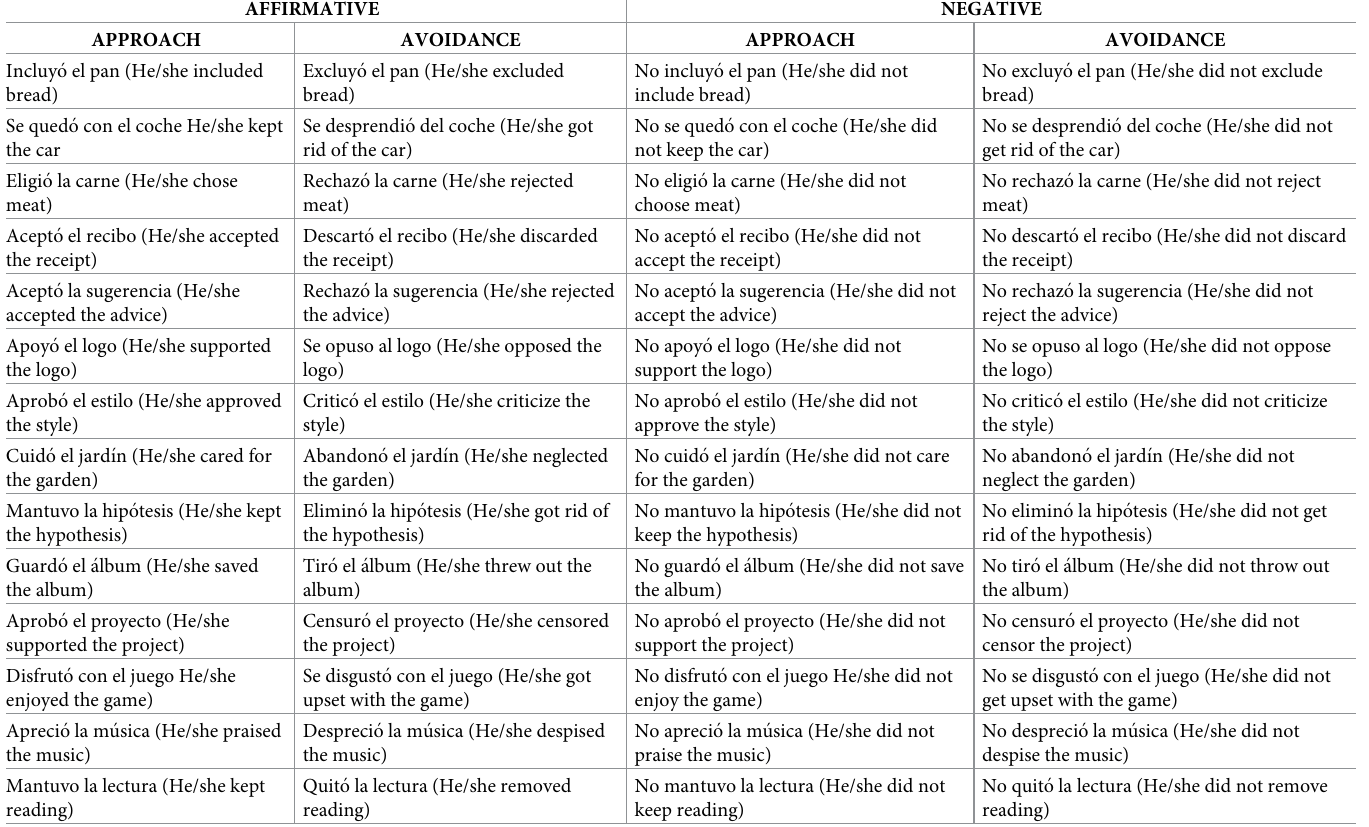
Table 1. List of approach and avoidance sentences (verb + target) in affirmative and negative version with approximate translation into English.